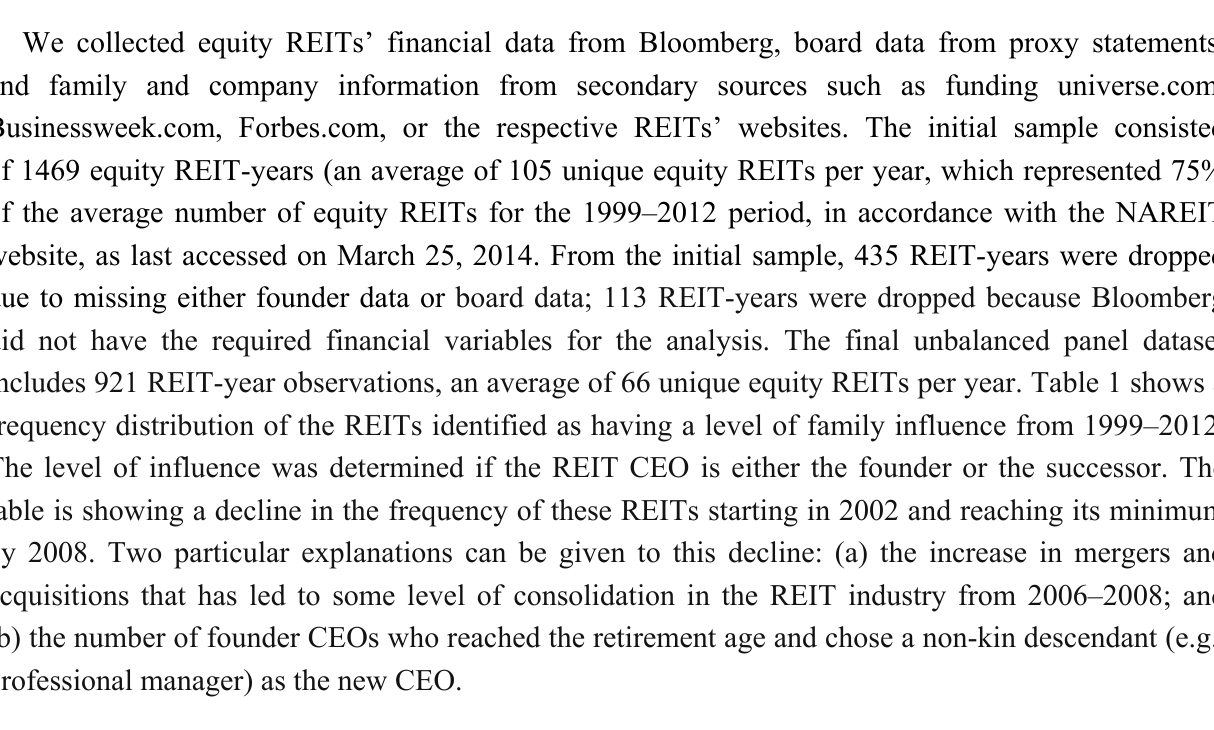
Table 1. Time series distribution of family sponsored Real Estate Investment Trusts